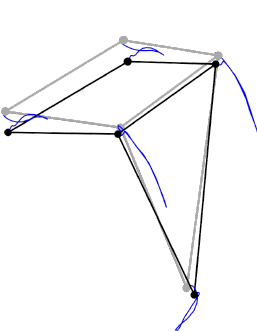
Figure 2. Trace illustration of the nod of the four head and the chin markers. The gray stick representation depicts the starting point, the black stick representation the end position, and the blue lines display the motion trajectory of the